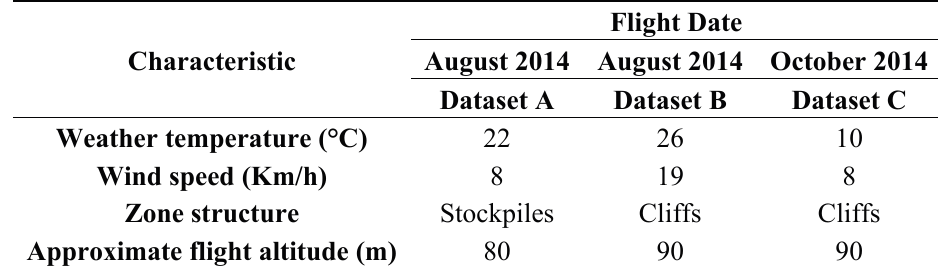
Table 1. Information of the data-acquisition